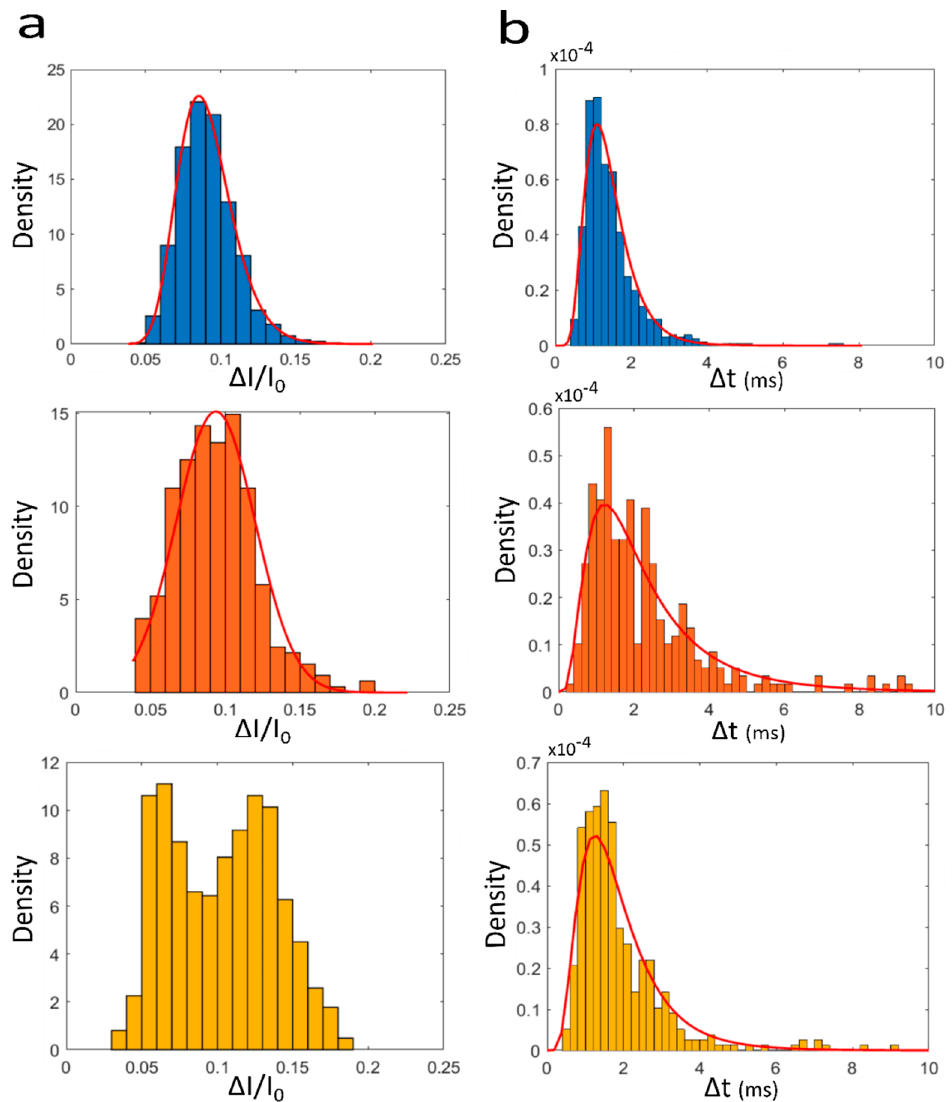
Figure 2. Distribution histograms of ( a ) the amplitude of the relative current blockade ( ∆ I / I 0 ) and ( b ) the dwell time ( ∆ t ) for the A 10 / T 10 (blue), A 40 / T 40 : (orange), T 40 (yellow). The events were recorded at 500 mV, the number of events n = 793, 332 and 634 for A 10 / T 10 , A 40 / T 40 and T 40 , respectively. The results were obtained using pore 1 d t = 3 nm, d b = 200 nm. The density ( d i ) is the frequency ( f i ) of event relative to the sample size ( n ) and the bin width (w i ) d i = f i where w i = 0.01 and 200 for ∆ I / I 0 and ∆ t , respectively.